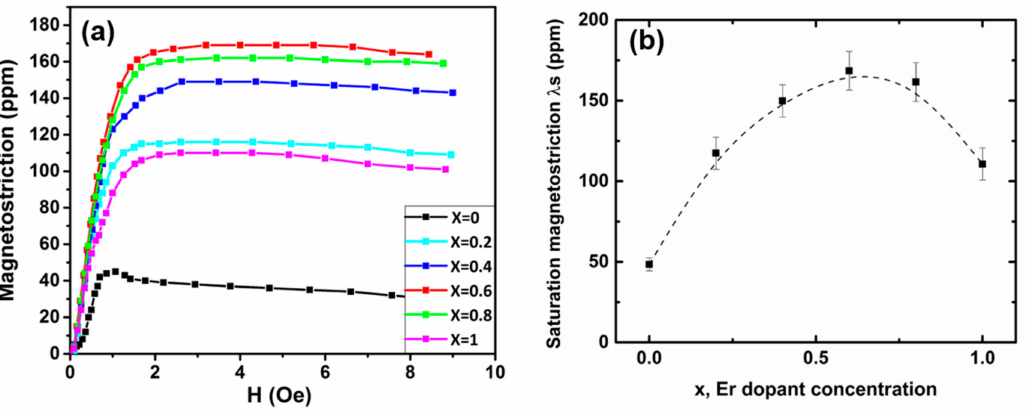
Figure 6. ( a ) Magnetostriction of the (Fe 0.83 Ga 0.17 ) 100 − x Er x (0 < x < 1) alloys as a function of the applied magnetic field. An enhanced saturation magnetostriction value ( λ s ) of more than 250% is measured relative to the parent compound; and ( b ) change in λ s as a function of the Er dopant concentration ( x